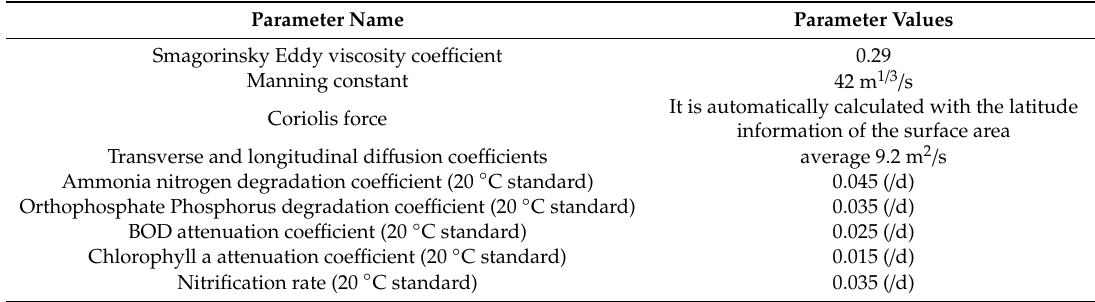
Table 5. The calibrated parameter values of the coupling model.